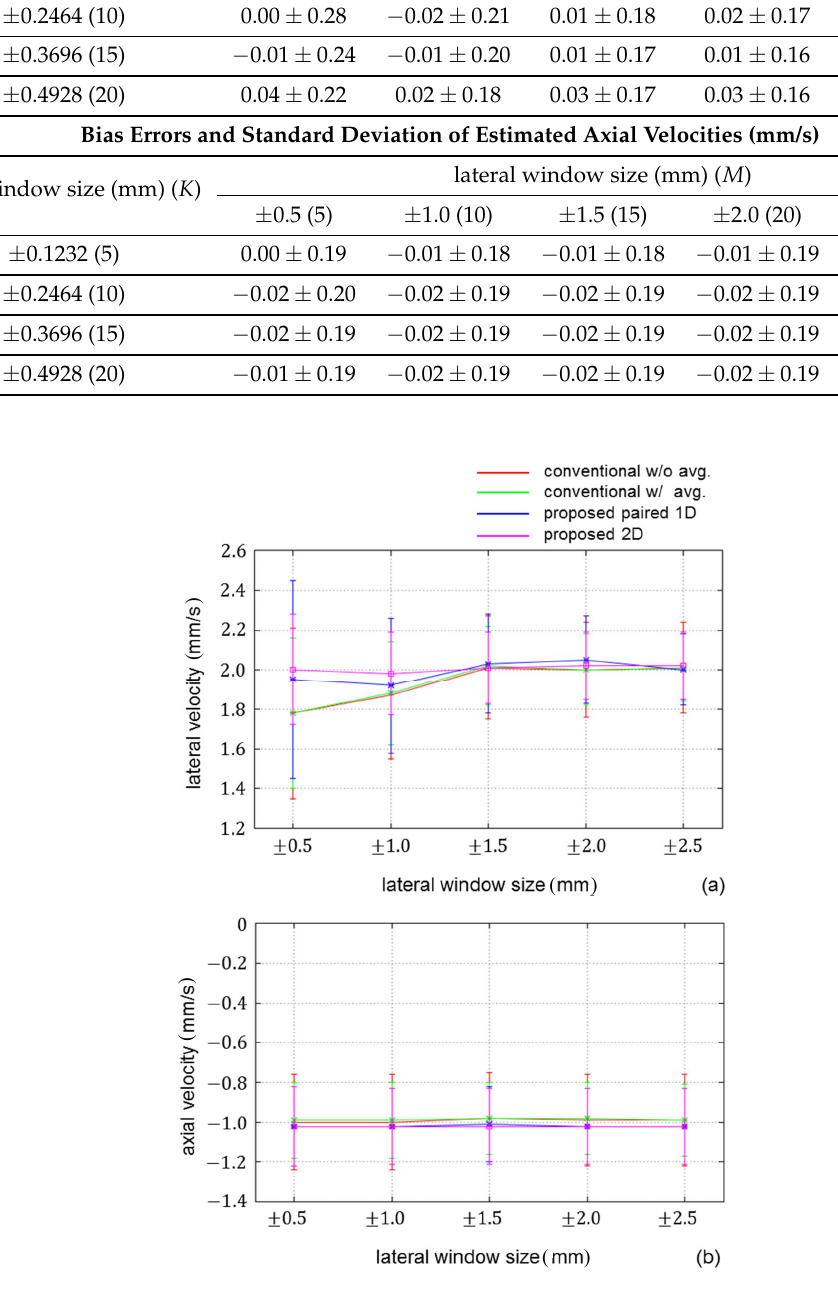
Figure 6. Lateral ( a ) and axial ( b ) velocity estimates obtained by respective methods.